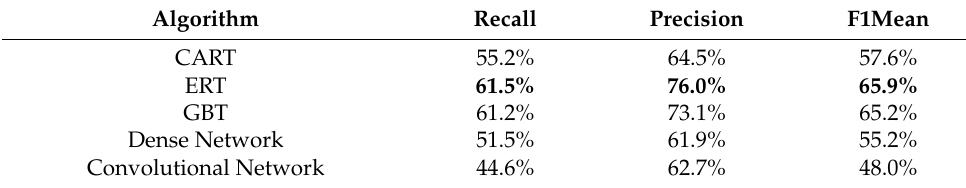
Table 6. Average performance values across each algorithm for behavior